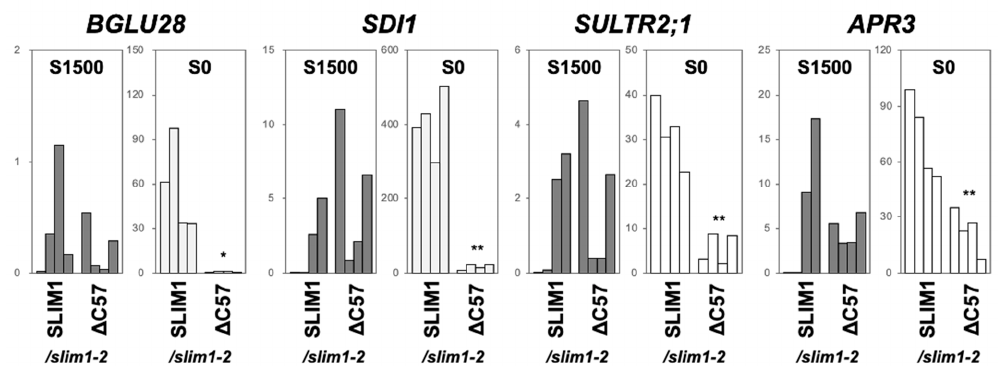
Figure 4. Transcript levels of − S-responsive genes in the complemented lines. Transcript levels of BGLU28 , SDI1, SULTR2;1, and APR3 in the roots of four independent lines of SLIM1/slim1-2 and Δ C57 /slim1-2 were determined by qRT-PCR with the same root-derived RNA used for the SULTR1;2 transcript expression analysis in Figure 3b. Asterisks indicate significant differences between SLIM1/slim1-2 and Δ C57 /slim1-2 in S1500 and S0 conditions (Student’s t -test; ** p < 0.01, * 0.01 ≤ p < 0.05). To gain further insights into the − S-responsive phenotypes affected by the C-terminal 57 aa deletion ( Δ C57), we analyzed the tissue sulfate, cysteine, and GSH levels. Sulfate levels were not different among the plant lines under both S1500 (S-sufficient) and S0 (–S) conditions (Figure 5). Cysteine levels were similar between the parental line and slim1-2 but slightly increased in Δ C57/ slim1-2 compared to SLIM1/ slim1-2 under both S1500 and S0 conditions. GSH levels were lower in slim1-2 than in the parental line under S1500 and lower in Δ C57/ slim1-2 than in SLIM1/ slim1-2 under S0 conditions (Figure 5). These results suggest that sulfate assimilation is restored by overexpression of the full-length SLIM1 to complement slim1-2 under –S, but not with the C-terminal truncated form Δ C57.